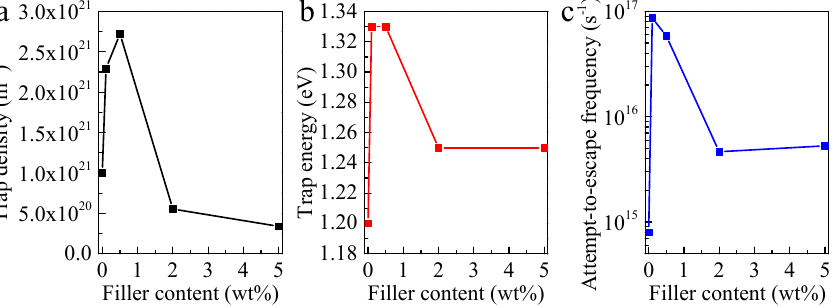
Figure 3. Trap density ( a ), trap energy ( b ), and attempt-to-escape frequency ( c ) versus filler content of LDPE/Al 2 O 3 nanocomposites.